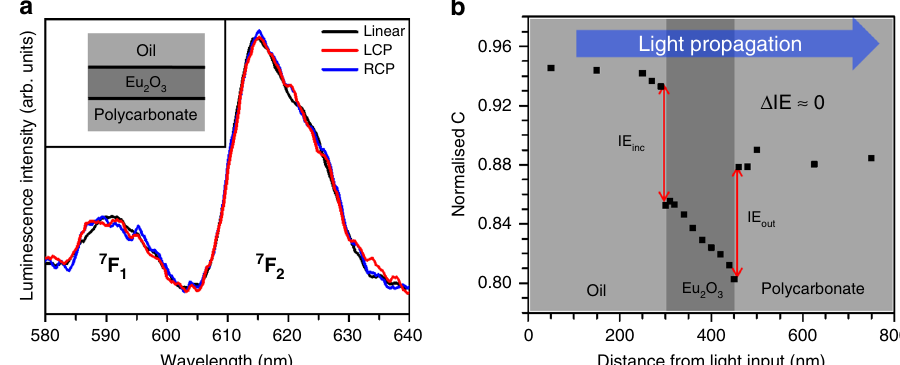
Fig. 3 Optical chirality transfer with equivalent interfaces (oil-Eu 2 O 3 -polycarbonate). a Luminescence spectra normalised to 7 F 1 for LP (black) and LH (red) and RH (blue) CPL. b The equivalent numerical simulation to that is shown in Fig. 2d for the oil-Eu 2 O 3 - polycarbonate case, using thicknesses of 300 nm (oil), 150 nm (Eu 2 O 3 ) and 350 nm (polycarbonate) for the three fi lms. light. In Fig. 2d are the numerical simulations of C for an unstructured fl at Eu 2 O 3 fi lm in air. As expected, given the modulated the magnitude of Δ IE using nanostructured chiral meta fi lms (see Supplementary Fig. 3 for images). The Eu 2 O 3 from refractive indices (RI) of air (RI = 1) and polycarbonate (RI = which these fi lms are composed is identical to that above and is 1.619) IE inc > IE out and Δ IE = 0.05 for both LCP and RCP light. amorphous and achiral on atomic length scales, so that Eu 3 + does By covering the air interface with microscope oil (RI = 1.518), not display any intrinsically chiral properties. Scattering CP and the RI environment becomes closer to that of the polycarbonate LP light from chiral nanostructures has previously been shown to substrate, so that the numerical simulations, Fig. 3a, give Δ IE ≈ 0 create near fi elds, which exhibit spatial variations in both inten- for both CP of light. In the absence of a net exchange of chirality, sity and C (Supplementary Fig. 4). The values of C can locally be Fig. 3b shows no difference between LP and CP spectra, either greater or less than that of the incident CPL alone 30 . indicating no signi fi cant symmetry-reducing perturbation. NATURE COMMUNICATIONS| (2020) 11:5169